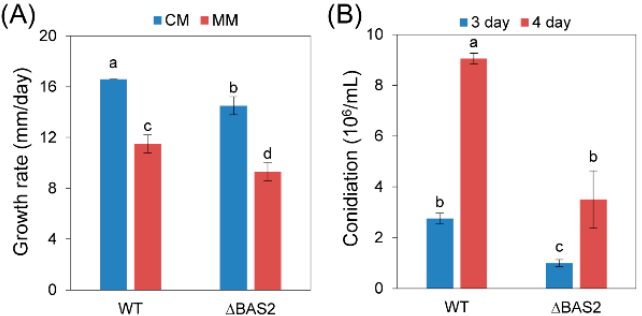
Figure 1. Growth rate and conidiation assays. ( A ) Growth rate of wild-type (WT) and Δ BAS2 cultured on complete medium (CM) and minimal medium (MM); ( B ) conidiation of WT and Δ BAS2. Bars represent standard deviation (SD). Columns with different letters indicate significant difference ( p < 0.05).